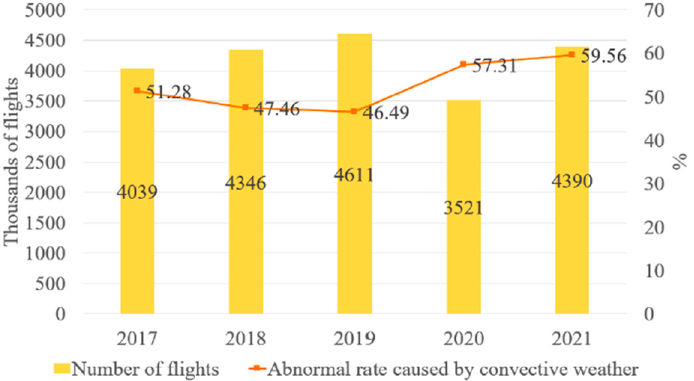
Figure 1. Number of fl ights and irregularity rate due to weather from 2017 to 2021 in China.